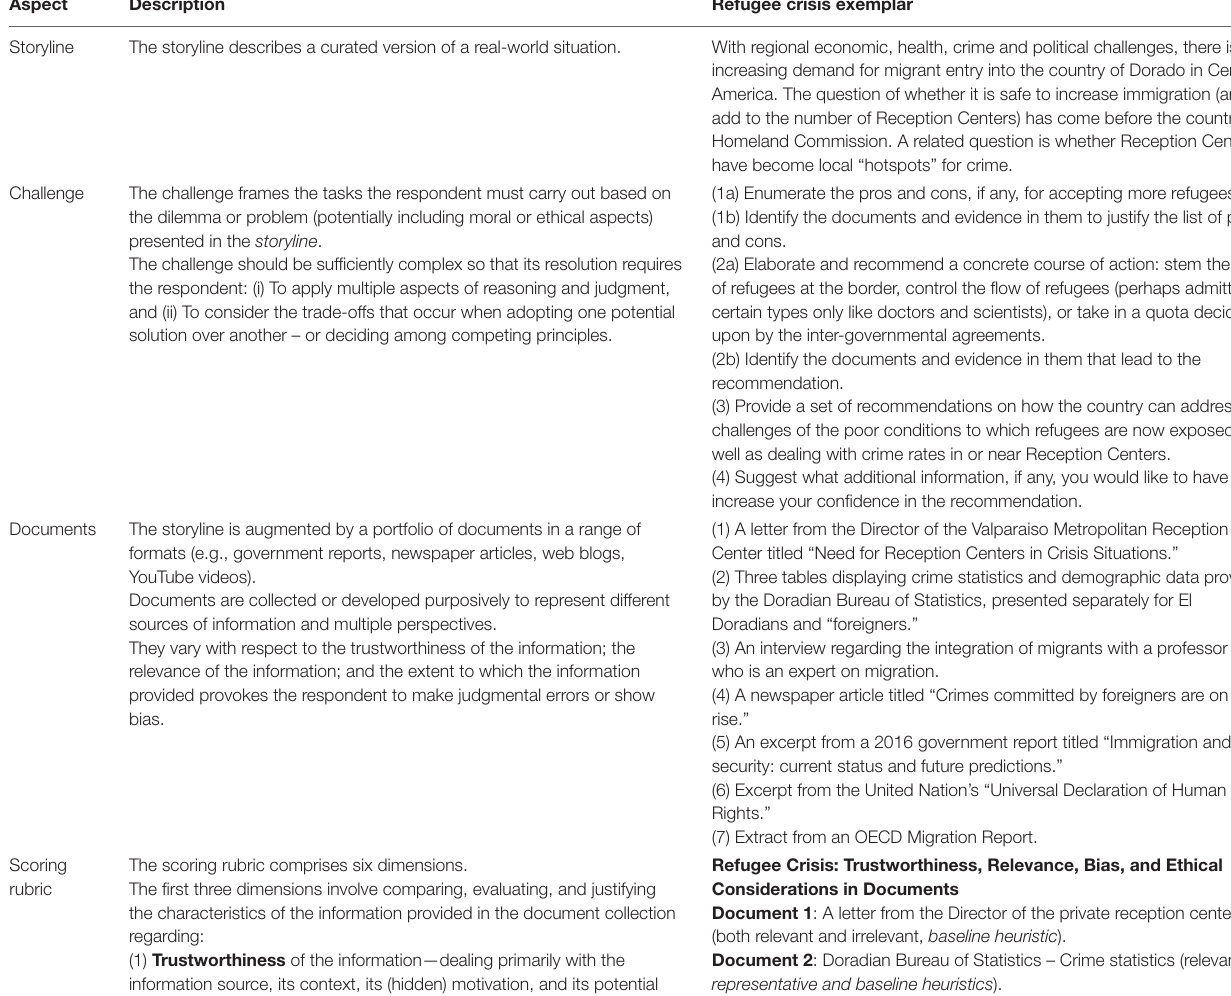
TABLE 1 | The iPAL assessment framework. Description Refugee crisis